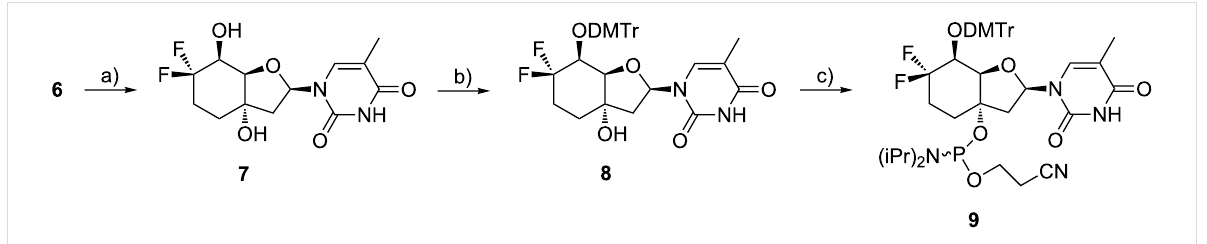
Scheme 2: Synthesis of the thymidine phosphoramidite building block 9 . Reagents and conditions: a) HF-pyridine, DCM/pyridine 5:1, 0 °C to rt, 2.5 h, 64%; b) DMTr-OTf, DCM/pyridine 1:2, rt, 22 h, 56%; c) CEP-Cl, DIPEA, THF, rt, 3 h, 73%.